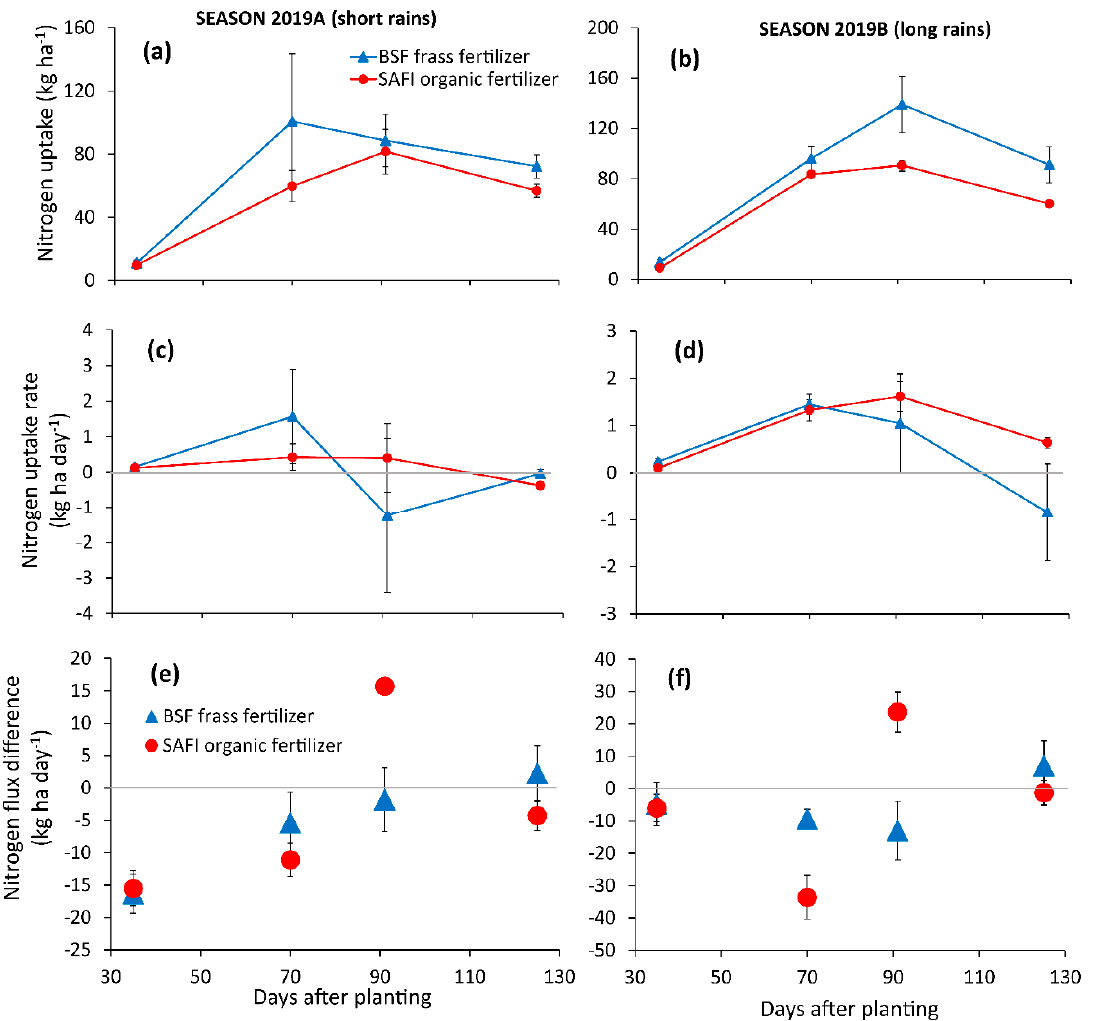
Figure 4. Effect of BSF frass and SAFI organic fertilizers on maize nitrogen uptake ( a , b ),